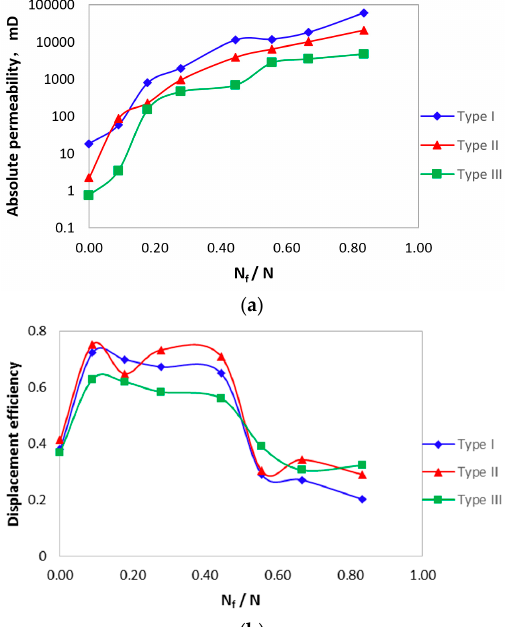
Figure 9. The influence of fracture density on absolute permeability and displacement efficiency. ( a ) The influence of fracture density on absolute permeability; ( b ) The influence of fracture density on displacement efficiency.